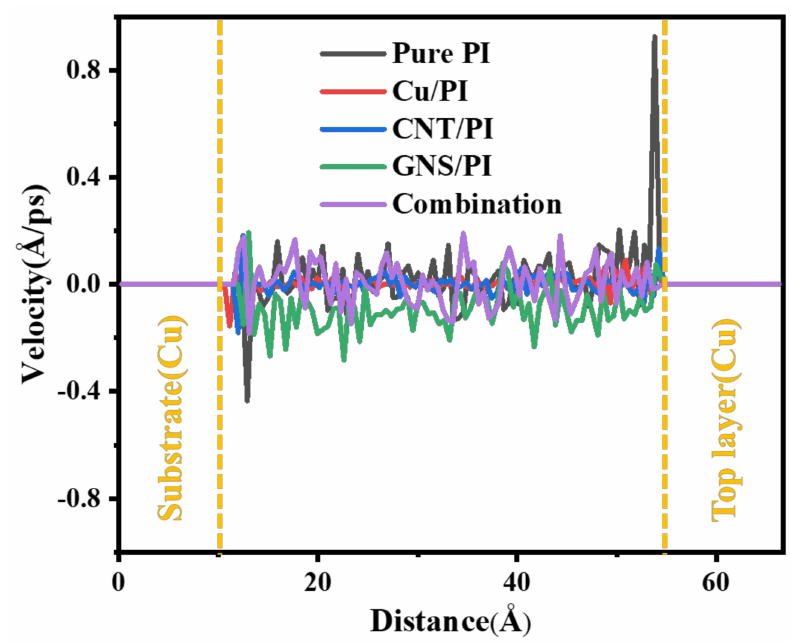
Figure 13. Velocities profiles of friction